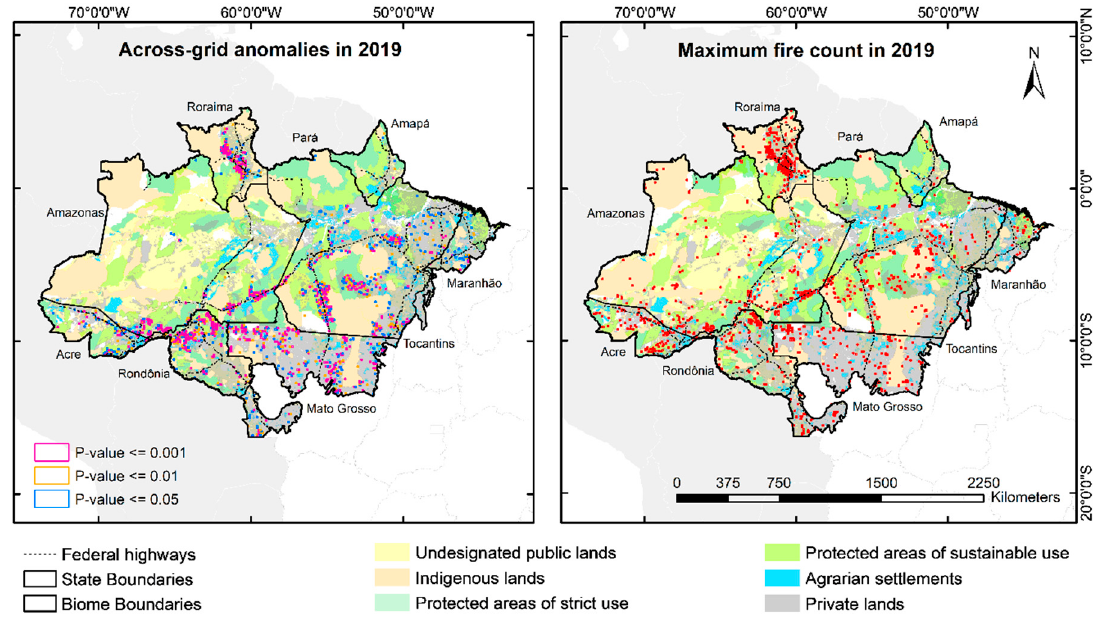
Figure 4. Spatial distribution of the two types of fire anomaly across the Brazilian Amazon biome, Amazonian states, and land tenure categories. The first map shows grid-cells with fire occurrence defined as across-grid anomalous (cells with a z-score for fire occurrence two standard deviations above the average across cells), classified according to their p -values. The second map shows, in red, the grid-cells in which fire occurrence in 2019 was the maximum of the 2003–2019 period.